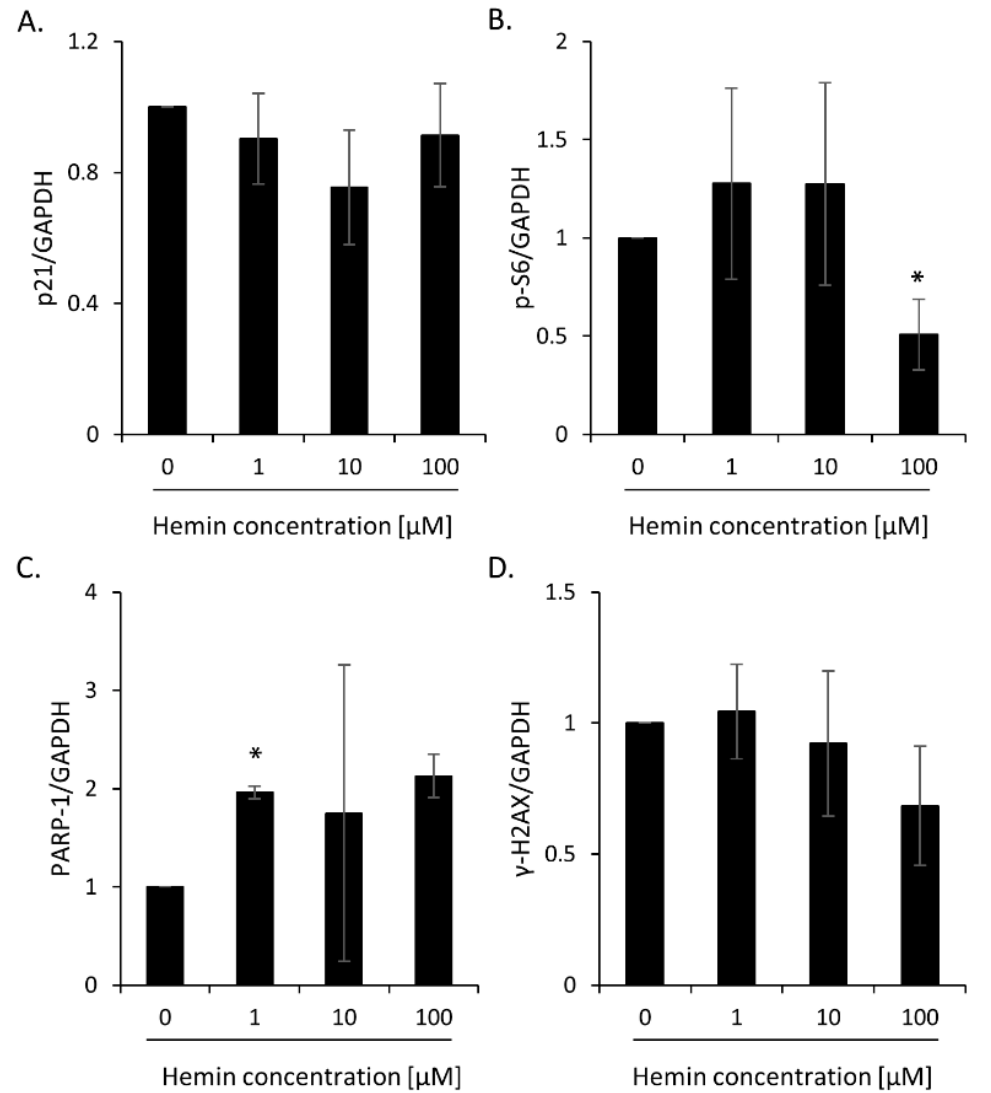
Figure A2. Evaluation of protein expression in HCT116 cells treated with 2.5 µ M IRINO subjected to 1, 10, or 100 µ M hemin: cell cycle inhibition and DNA repair markers. Quantification is based on the densitometry analysis performed with the use of ImageJ software. Data are shown as the ratio of protein amount to respective protein loading control (GAPDH): ( A ) p21; ( B ) p-S6; ( C ) PARP-1; ( D ) γ -H2AX. Each bar represents mean ± SEM, n ≥ 3; * p < 0.05—hemin concentration vs.